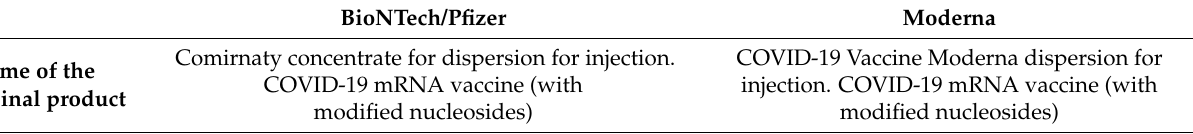
Table 8. Comparison of BioNTech/Pfizer and Moderna vaccines based on mRNA and lipid nanoparticles. BioNTech/Pfizer Moderna Comirnaty concentrate for dispersion for injection. COVID-19 mRNA vaccine